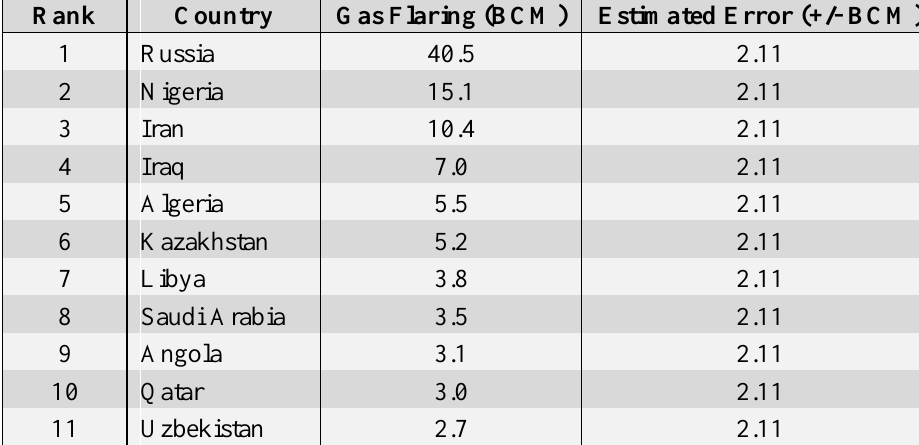
Table 3. Year 2008 top twenty gas flaring